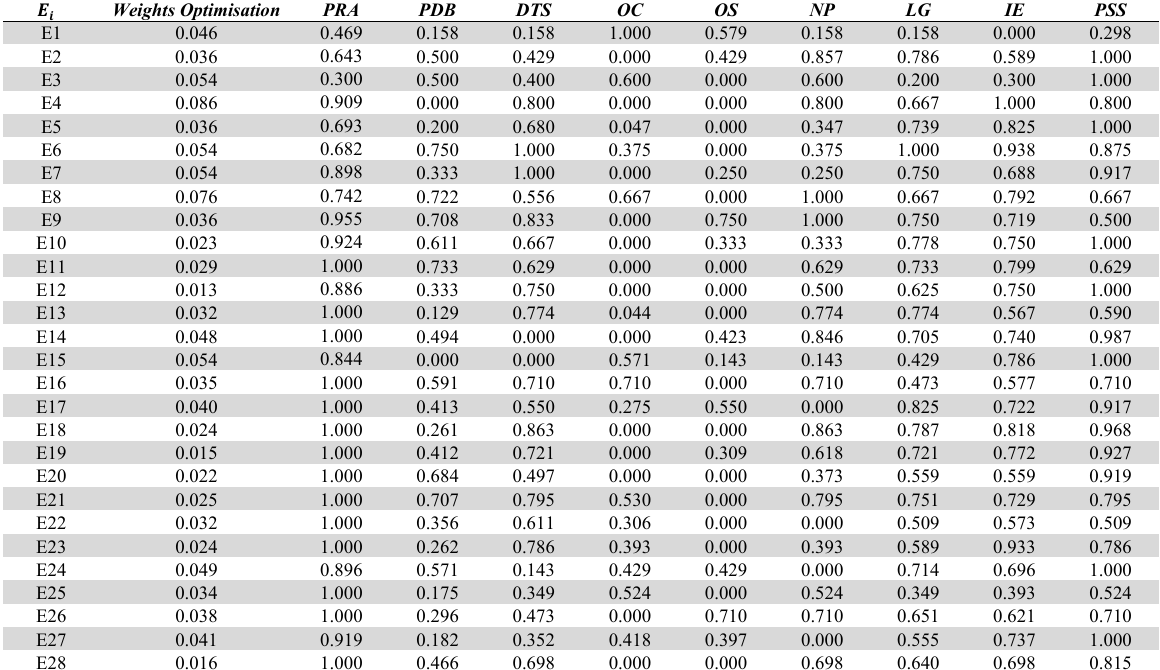
Normalised decision-making matrix 𝑬 𝒊